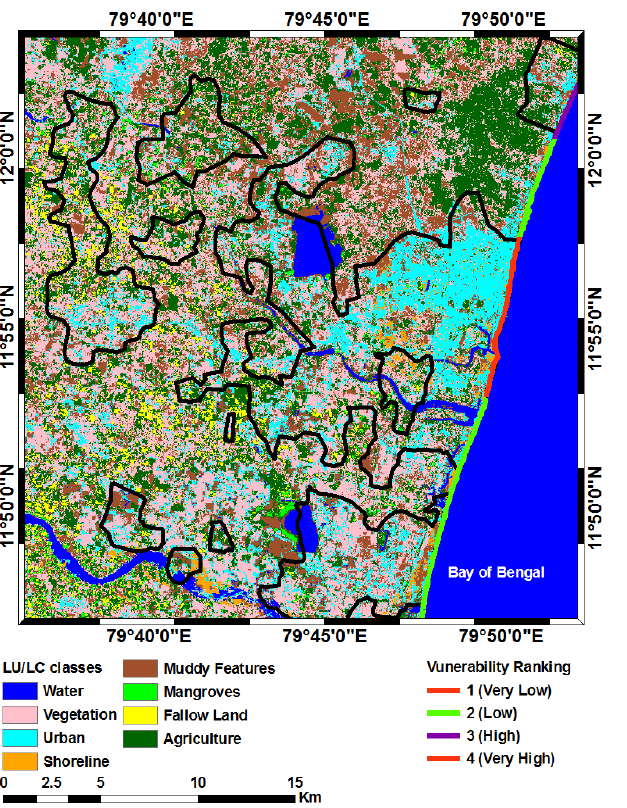
Fig. 9. Vulnerability ranking map of road